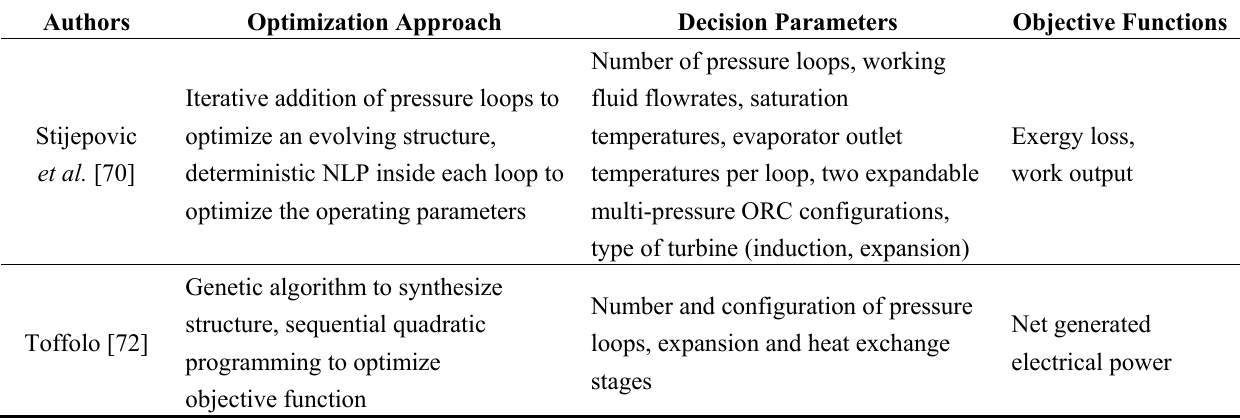
Table 6. Optimum cycle structure and operating/sizing parameters evolve during the optimization search; the optimum cycle structure is not pre-determined but results from